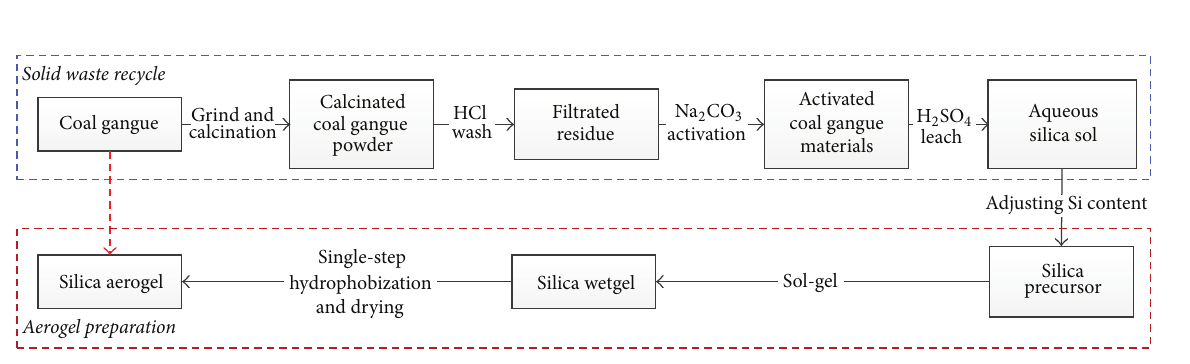
Figure 1: Schematic presentation of the main steps of silica aerogel preparation from coal